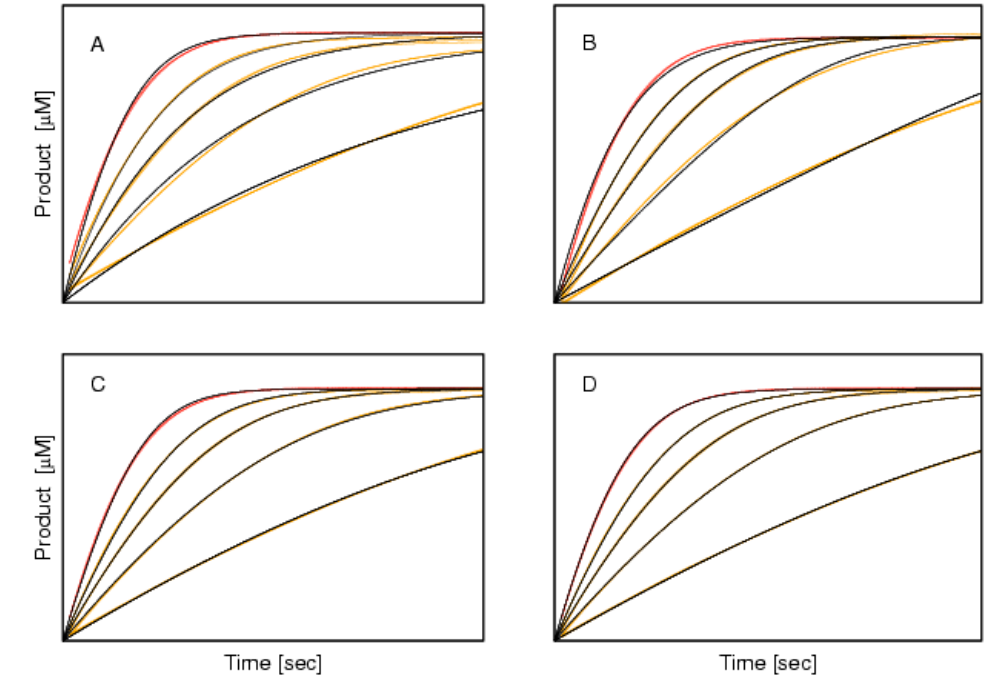
Figure 3. Progress curves for the inhibition of 50 μ MBSCh hydrolysis by horse BChE in the absence (red) and presence (orange) of sodium fluoride (0.25, 0.5, 1 and 2.5 mM, from the highest to the lowest, respectively). The black curves are theoretical, obtained for four types of reversible inhibition. ( A ) Competitive; ( B ) Uncompetitive; ( C ) Non-competitive; ( D ) Mixed. Note the agreement between the experimental and fitted curves. Table 1. Kinetics parameters for the inhibition of horse BChE by the eight inhibitors a .